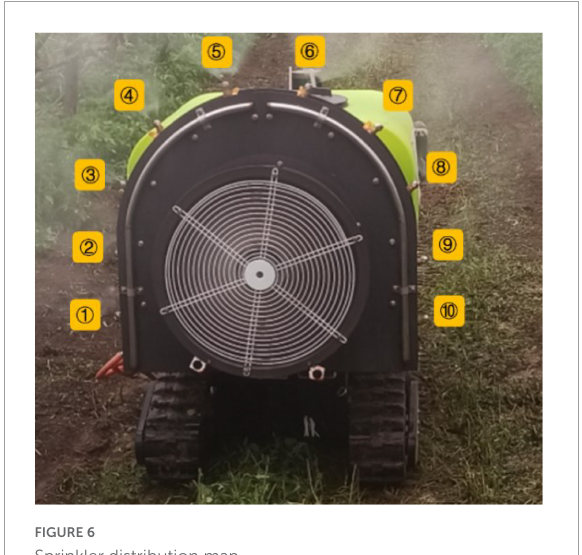
FIGURE6 Sprinkler distribution